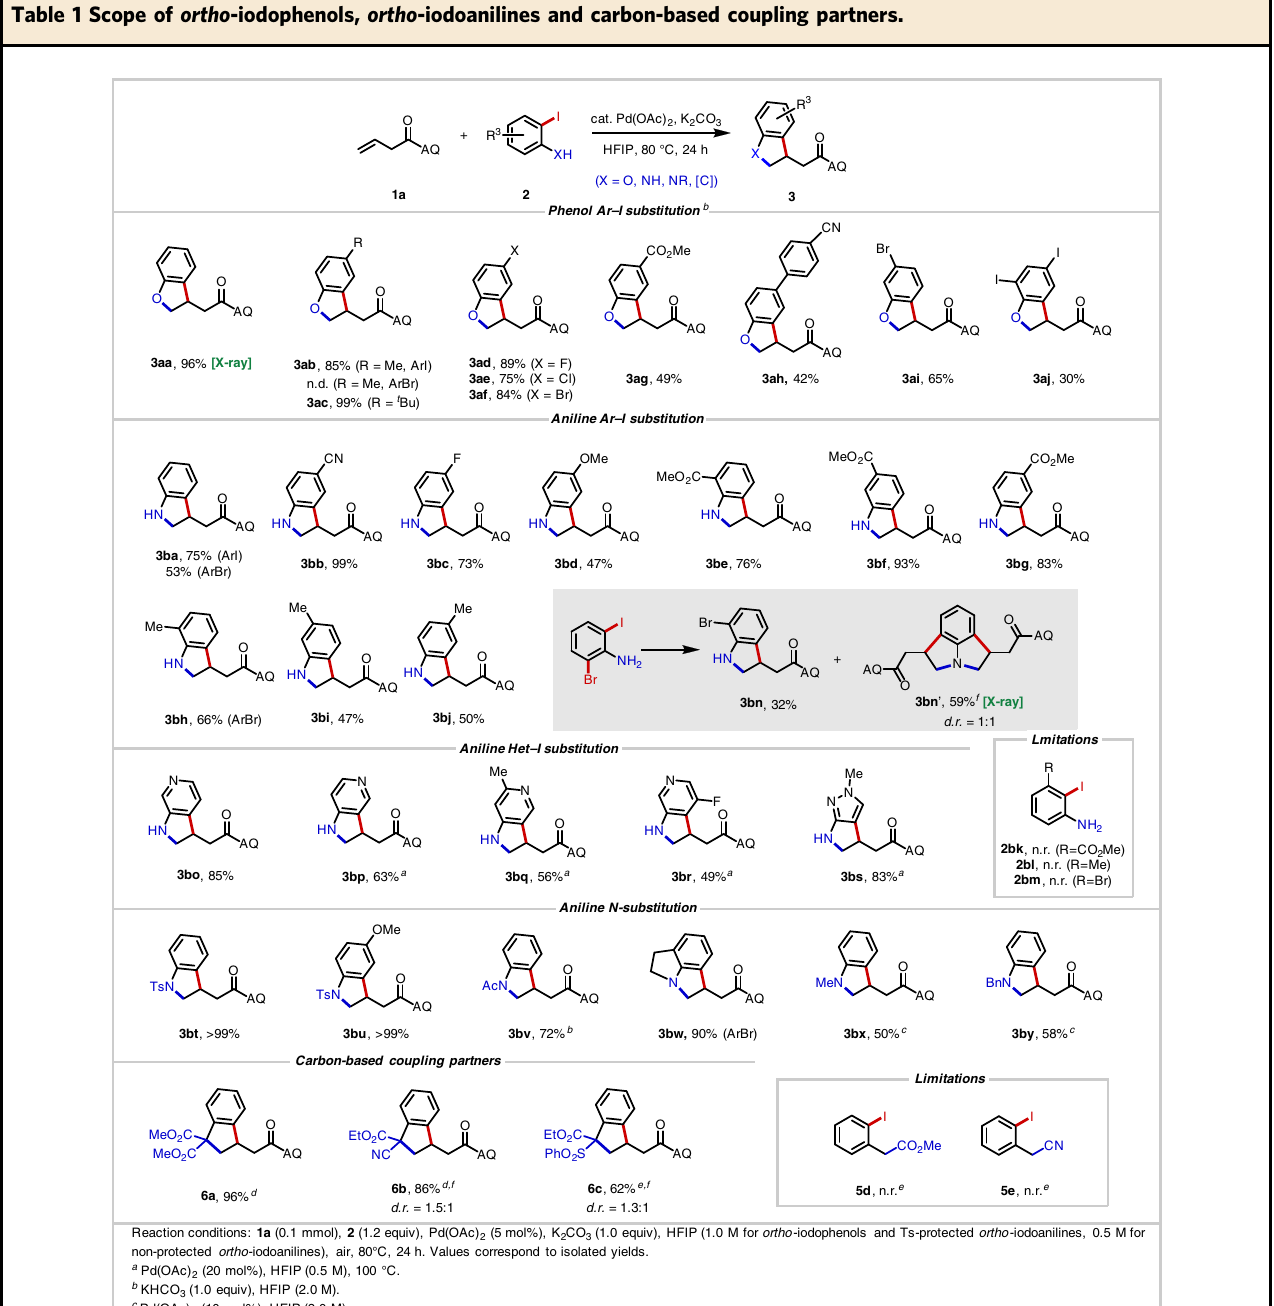
Table 1 Scope of ortho -iodophenols, ortho -iodoanilines and carbon-based coupling partners.